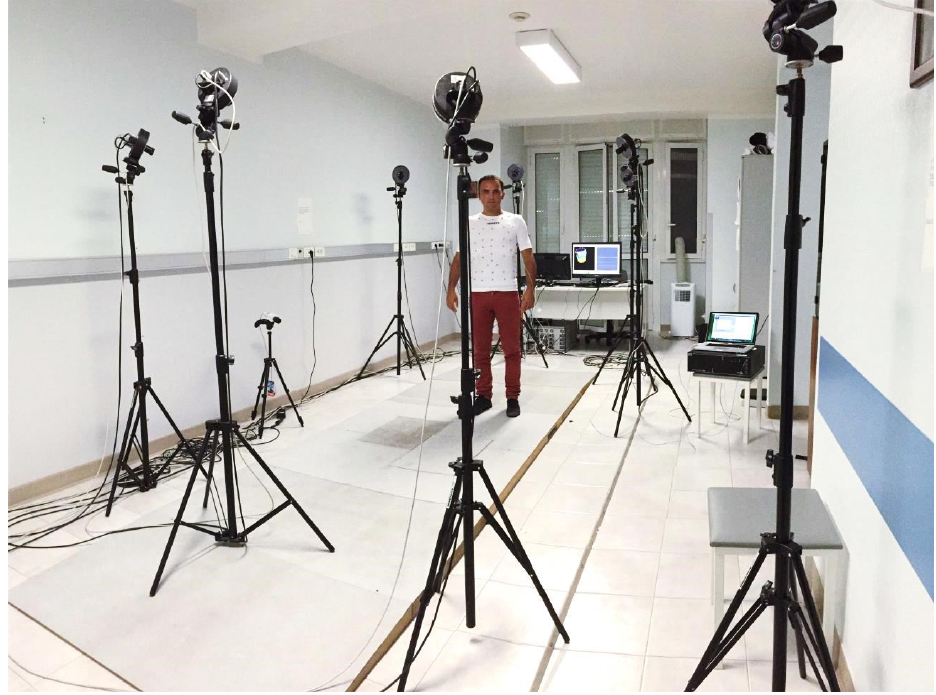
Figure 2. Picture of the experimental